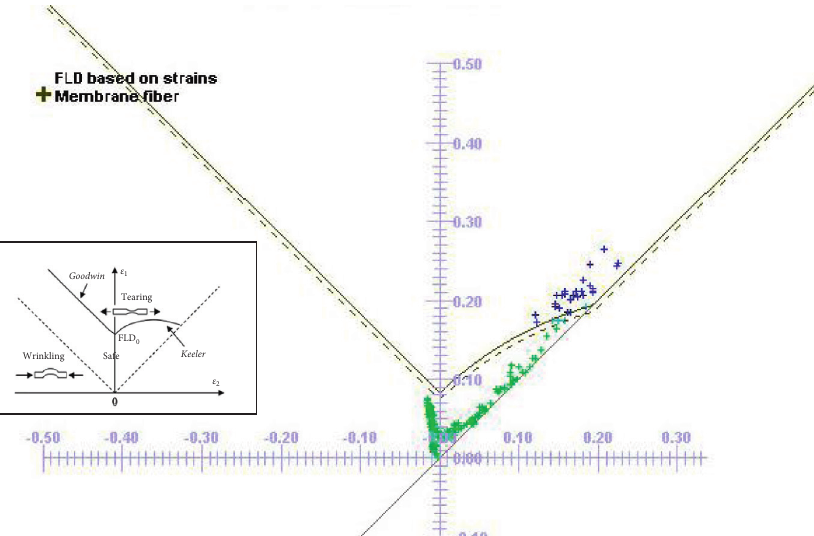
Figure 7: Graph to represent the strain developed on CP-Ti material induced while testing through formability limit diagram (FLD).